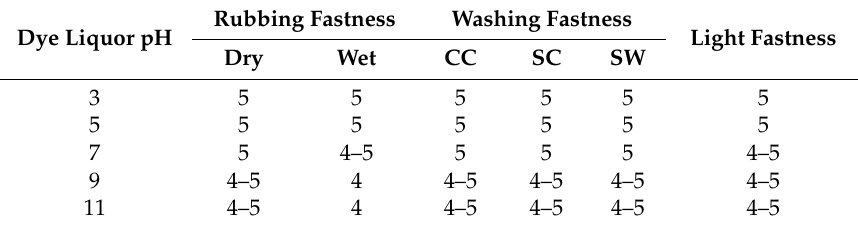
Table 6. The color fastness of dyed silk fabrics based on catalytic oxidation with laccase. Rubbing Fastness Washing Fastness Dye Liquor pH